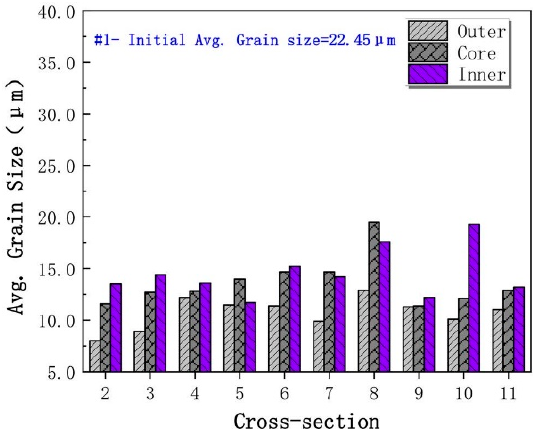
Figure 18. Locations of the cross-section in the rolled piece for microstructure observation samples [23] (Reprinted from ref. [23]).